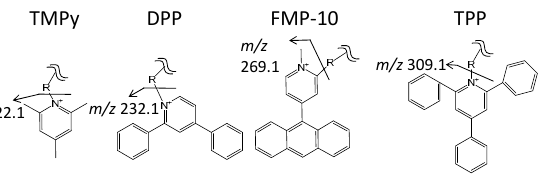
Figure 1. Chemical structure of derivatization reagents and fragmentation of derivatized reagents.